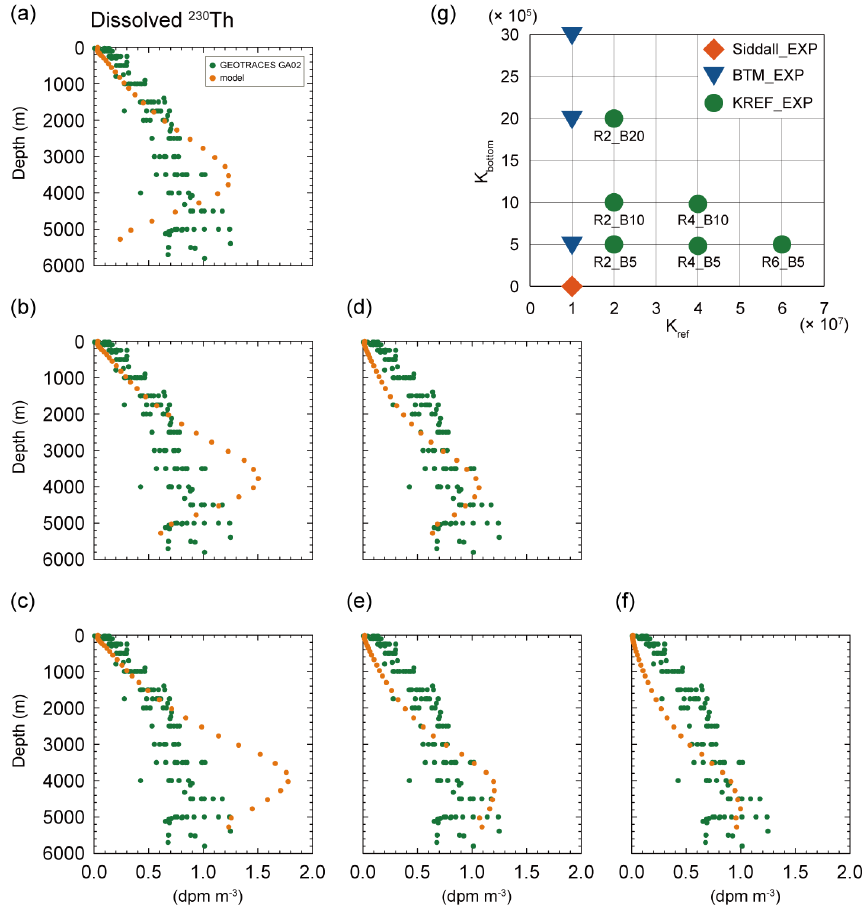
Figure 4. The vertical profile of dissolved 230 Th (the latitudinal mean along 30 ◦ W in the Atlantic Ocean) in various simulations of KREF_EXP: (a) R2_B20, (b) R2_B10, (c) R2_B5, (d) R4_B10, (e) R4_B5, and (f) R6_B5. The green and orange circles in (a) – (f) rep- resent the Atlantic GEOTRACES data (GA02; Schlitzer et al., 2018) and simulation results. Panel (g) summarizes the choice of parameters (i.e., K Th and K Th ) in each ref bottom